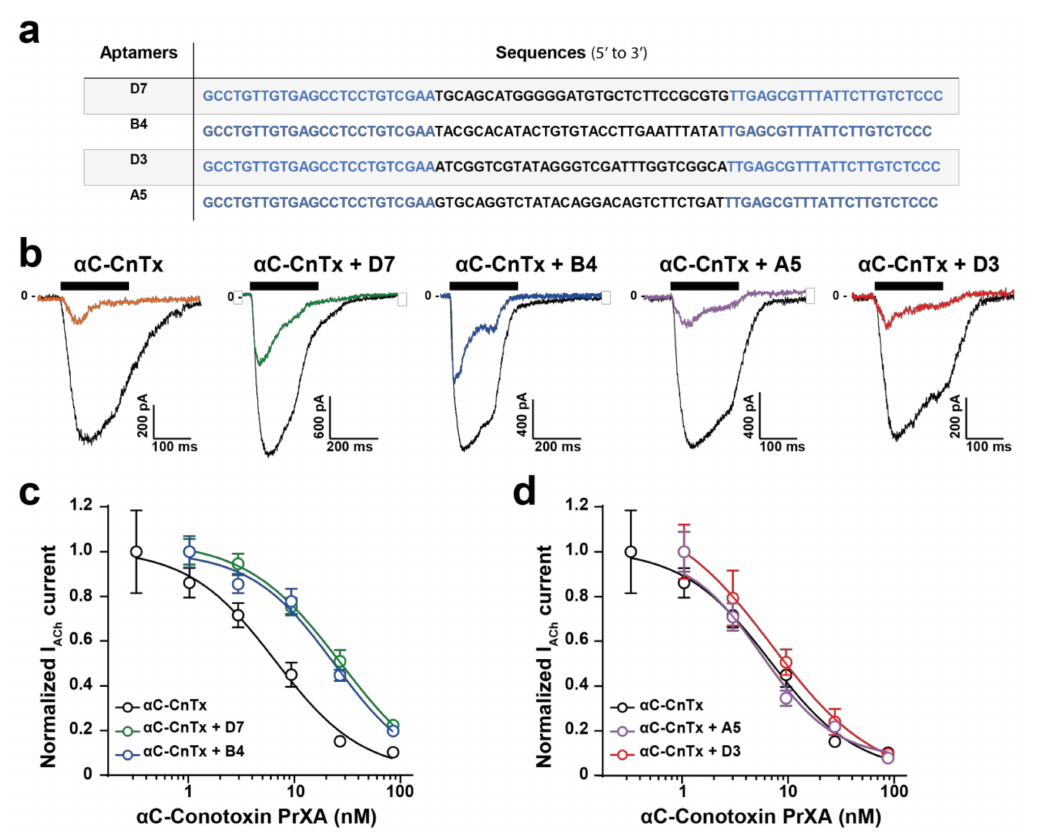
Figure 2. Impact of DNA aptamers on the α C-conotoxin PrXA-mediated inhibition of ACh response in TE671 cells. ( a ) Nucleotide sequences of the toxin-binding aptamers. Blue lettering corresponds to the conserved primers used in the CE-SELEX experiments, while normal lettering corresponds to the differentiating sequences between the aptamers. ( b ) Representative inward currents mediated by two applications of 100 µ M ACh. The first application occurs after a 20-min pre-incubation of the cells in the presence of 30 nM α C-conotoxin PrXA and 300 nM aptamer (colored trace), while the second application occurs after thorough washout of both the toxin and the aptamer (black